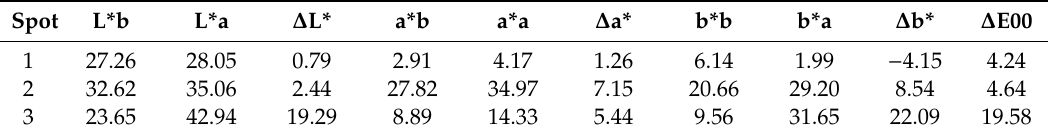
Figure 2. From left to right: sRGB of the Lazarus detail reconstructed from the HSI data at the end of the restoration procedure with the spots whose colorimetric values are reported in Table 1; images in grey scale of the b* colorimetric values before restoration; after being restored; image difference: ∆ b* colorimetric values (after–before). Table 1. Colorimetric values on three selected spots (average of 5 × 5 pixel, spectral acquisition sampled by 2) calculated from the spectra extracted by the cube-files acquired before (L* b , a* b , b* b ) and after (L* a , a* a , b* a ) the restoration process. CIE standard 2 ◦ observer and D65 illuminant, CIEDE2000 color-di ff erence formula